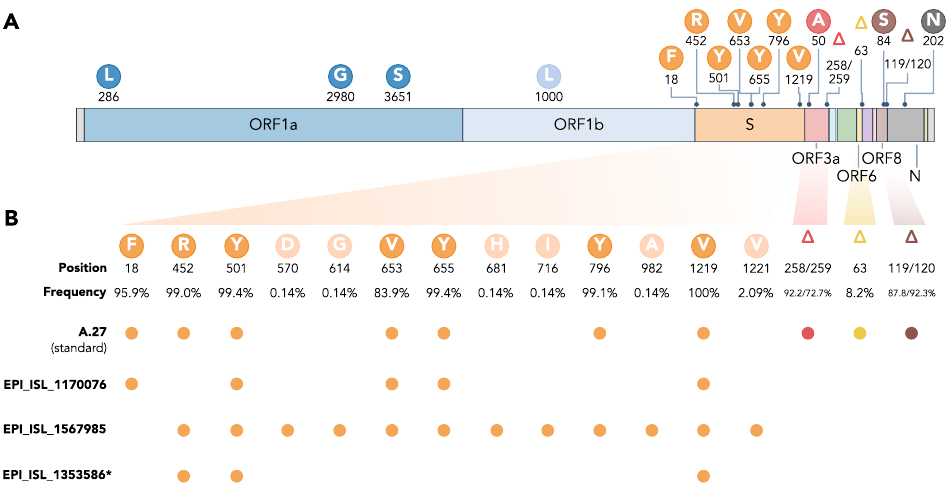
Figure 4. ( A ) Characteristic mutations leading to 17 amino acid alterations or deletions in A.27 genomes with a prevalence of at least 75%. Figure obtained and adjusted from [35]. ( B ) Overview of spike substitutions and high-frequency deletions in ORF3a, ORF6, and ORF8 in genomes assigned the A.27 lineage via pangolin. Frequencies are calculated based on the set of 718 A.27 genomes as used for the tree in Figure 2. Among “standard” A.27 genomes harboring all seven spike mutations and the three prevalent deletions, we also found three genomes that show a varying mutation profile in the spike and missing all three high-frequency deletions. While the deletion on ORF6 at position 63 is listed with a high frequency (higher 75%) on outbreak.info (accessed on 24 May 2021), we only observe a frequency of 8.2% in our data set based on a detection via NextStrain. * EPI_ISL_1353586 is not yet available on GISAID due to rejection of the sequence because of a